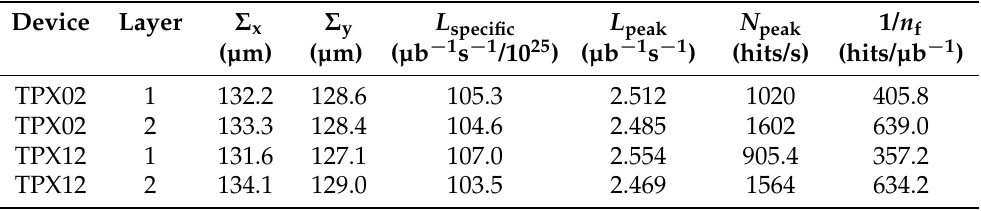
Table 22. vdM scan results for 2016 data. The scan was performed on 18 May (LHC fill 4945) and the first horizontal and vertical scans were used. The fit results for the first bunch-averaged horizontal Σ Σ x and vertical y convoluted beam sizes are given, as well as the specific luminosity. The peak luminosity takes the LHC operation parameters into account. The hit rate at the peak is averaged over the horizontal and vertical scans. Normalization factors (1/ n f ) convert hit rates to luminosities. The larger values are for the thicker sensor layer. Taken from Ref.